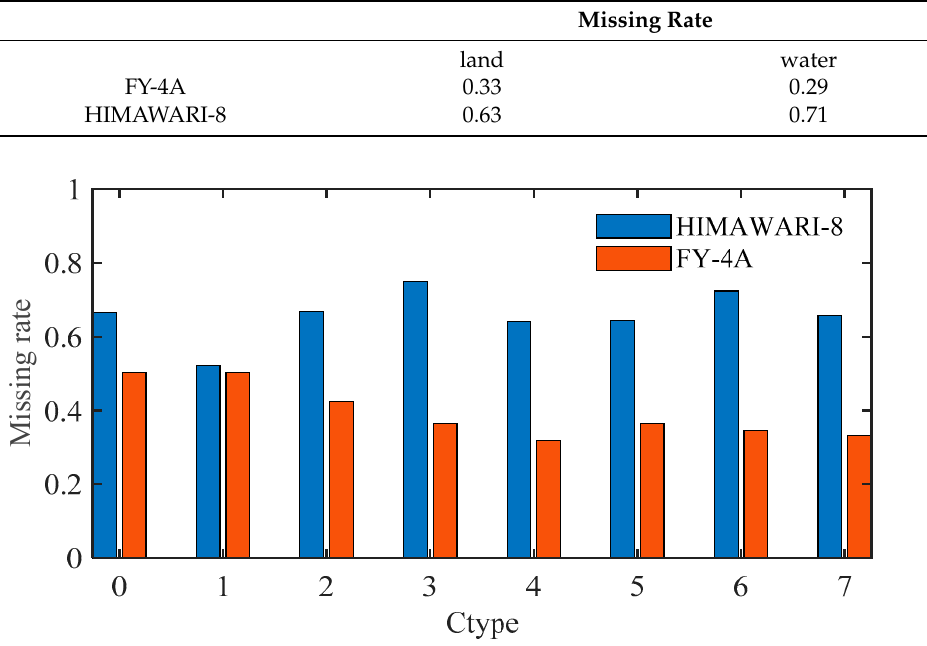
Figure 9. Missing rate of FY-4A and HIMWARI-8 under different cloud types: 0 represents low overcast, transparent, 1 represents low overcast, opaque, 2 represents transition stratocumulus, 3 represents low, broken cumulus, 4 represents altocumulus (transparent), 5 represents altostratus (opaque), 6 represents cirrus (transparent), and 7 represents deep convective